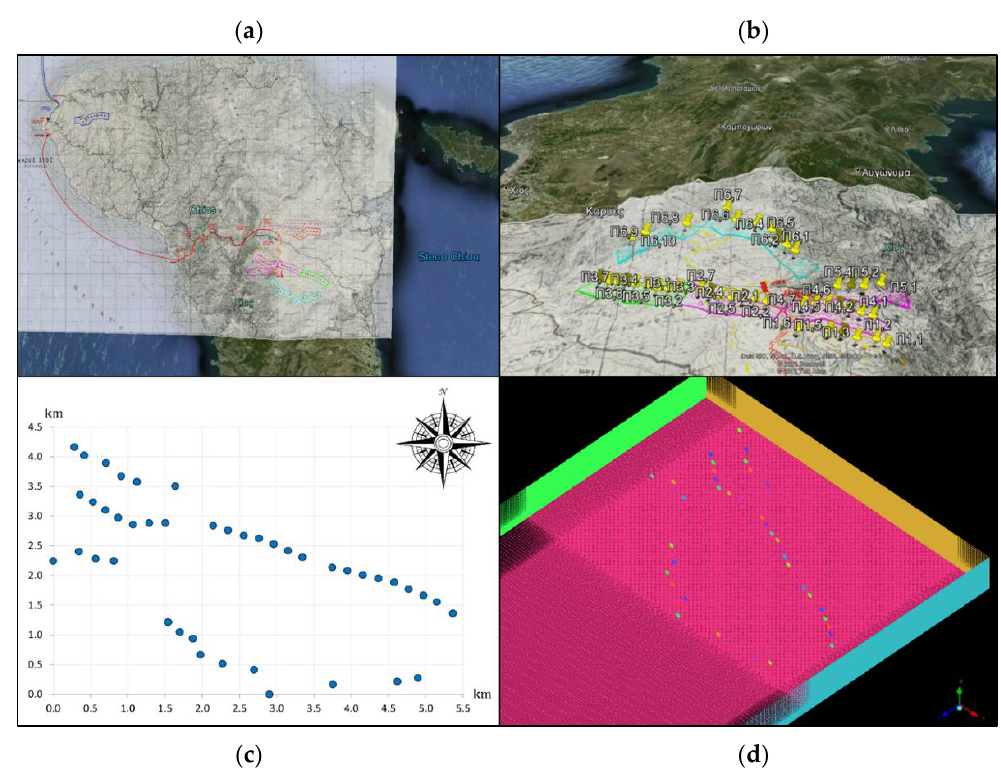
Figure 4. ( a ) Map of the project. ( b ) Positioning of the wind turbines in Google Earth. ( c ) Extraction to Cartesian coordinates. ( d ) Positioning of the wind turbines in the computational domain and detail of the grid refinement close to the area of interest.